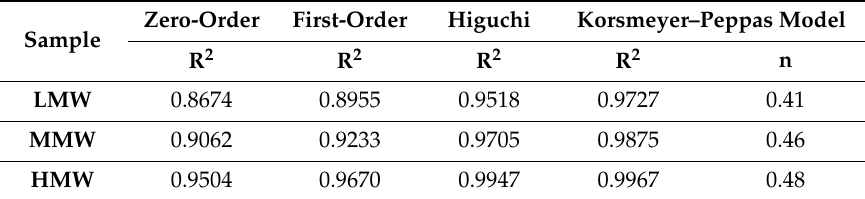
Figure 8. In vitro drug release studies. ( a ) Percentage of released betulin and ( b ) amount of betulin released from TE-loaded wound dressings. released from TE-loaded wound dressings. Table 4. In vitro release kinetics data of the TE-loaded electrospun fiber mats fitted to mathematical